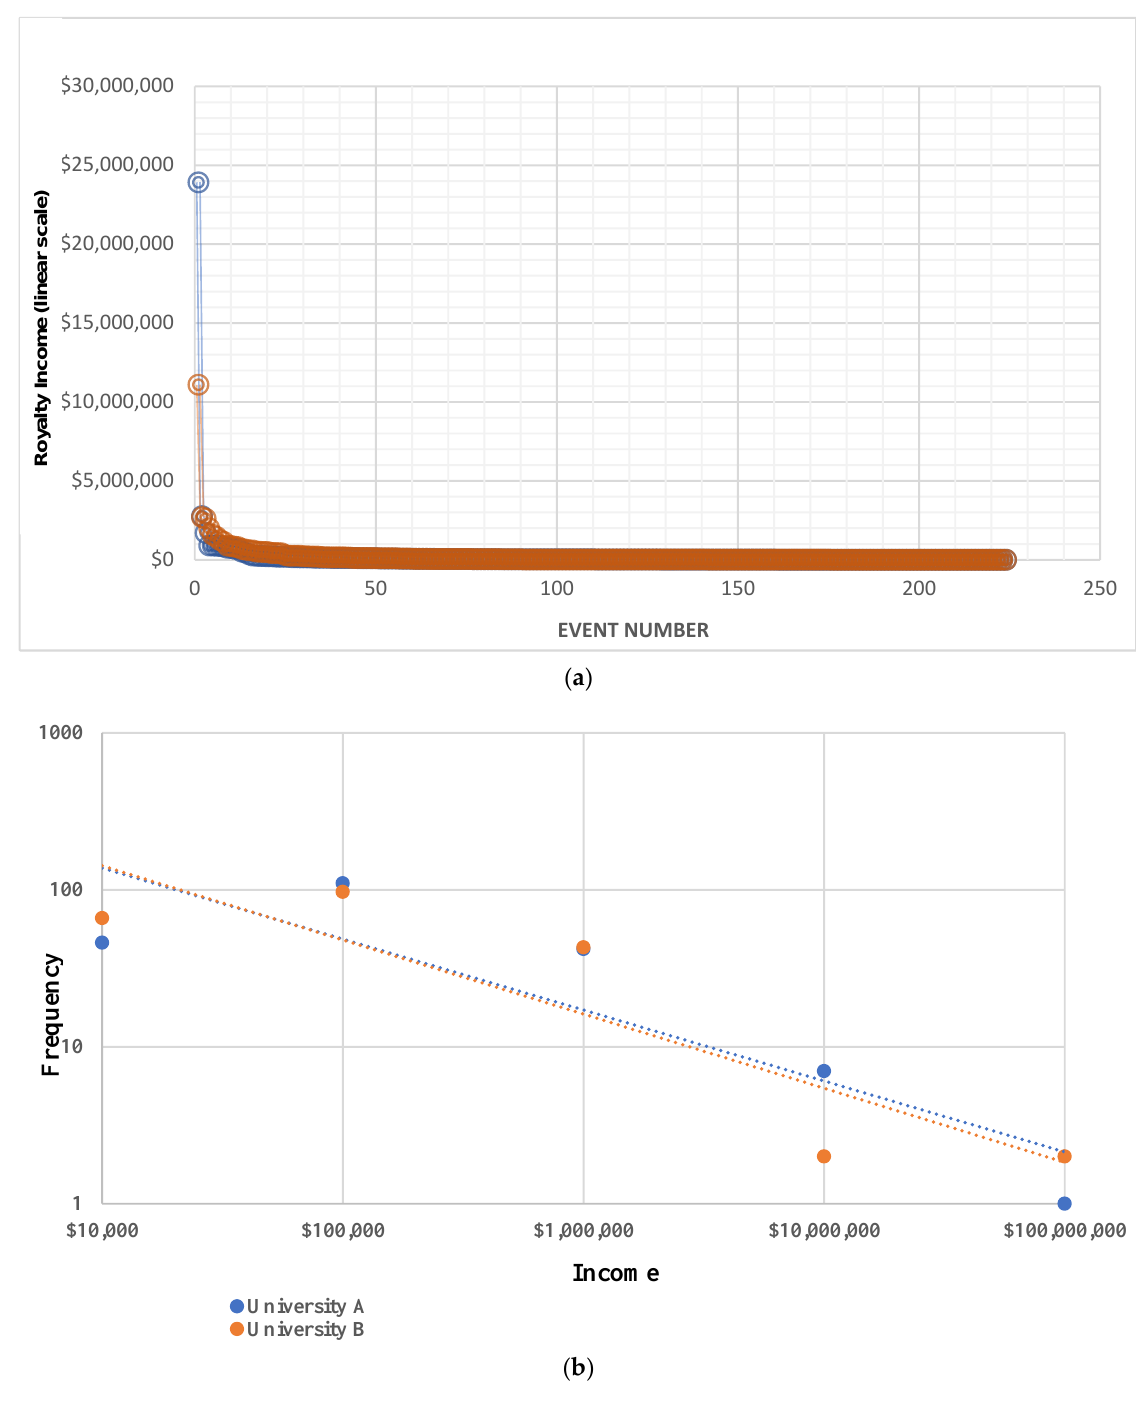
Figure 4. Two very different US research universities, yet, the two schools’ royalty incomes are similar and can be modeled as power-law distributions. ( a ) Event number vs. royalty income; ( b ) income vs. frequency.